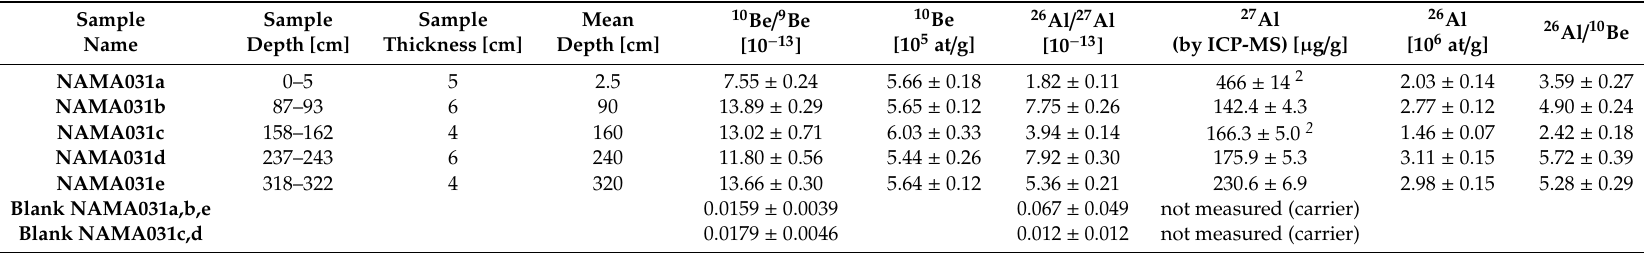
Table 2. Sample information and radionuclide data 1 . AMS data for NAMA031a,b,e (and Blank a,b,e) measured at DREAMS and for NAMA031c,d (and Blank c,d) measured at ASTER, respectively. Bulk rock density is 2.33 g / cm 3 for all